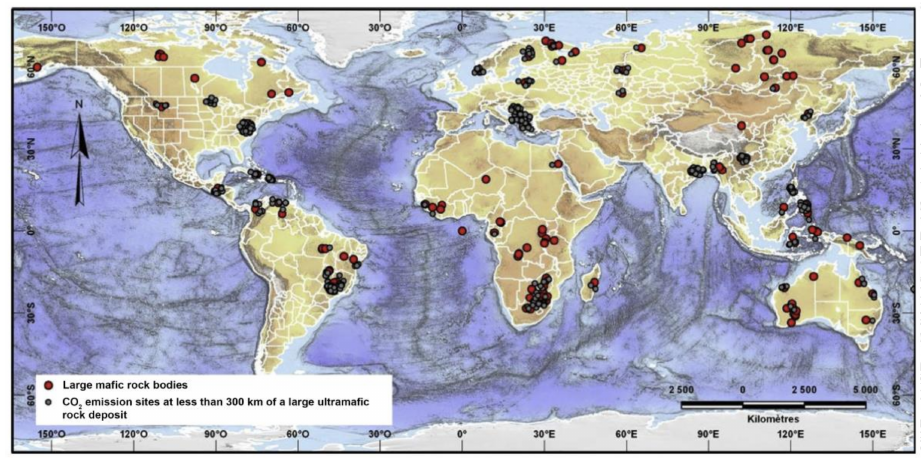
Figure 2. Large ultramafic rock-hosted ore deposits lying less than 300 km from a CO 2 -emission site. Reprinted with permission from Bod é nan et al. [74]. Copyright 2014 Elsevier